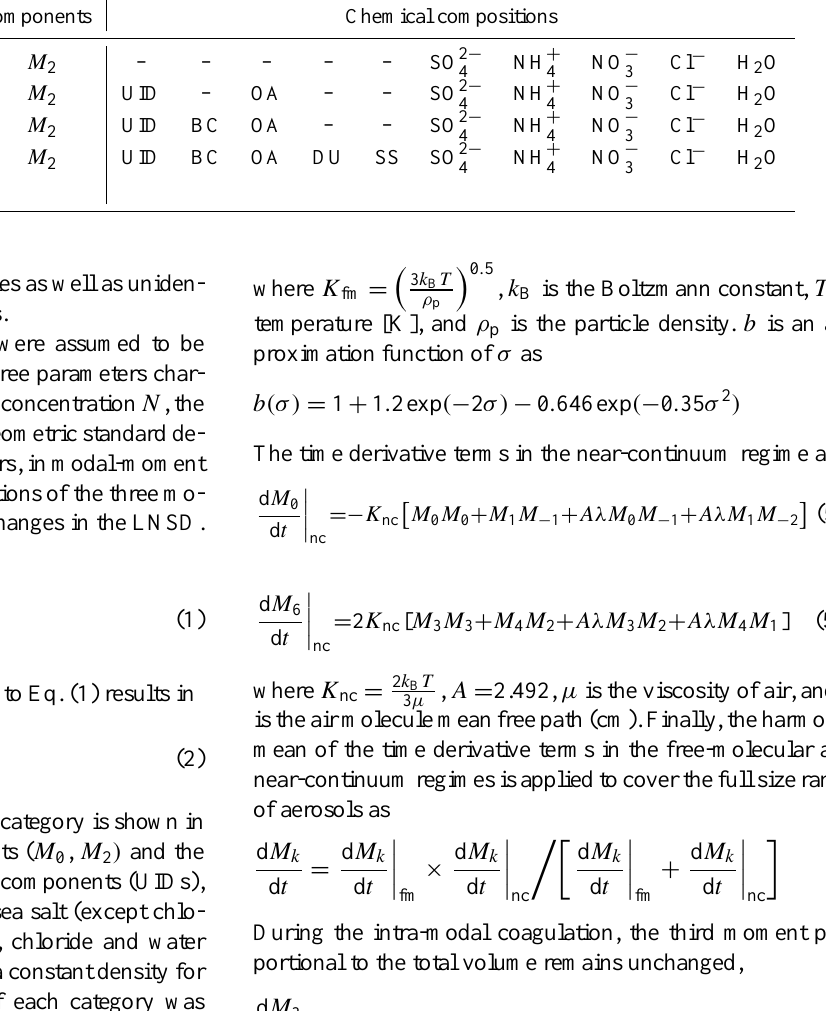
Table 2. Aerosol categories and transported variables in the RAQM2 model.